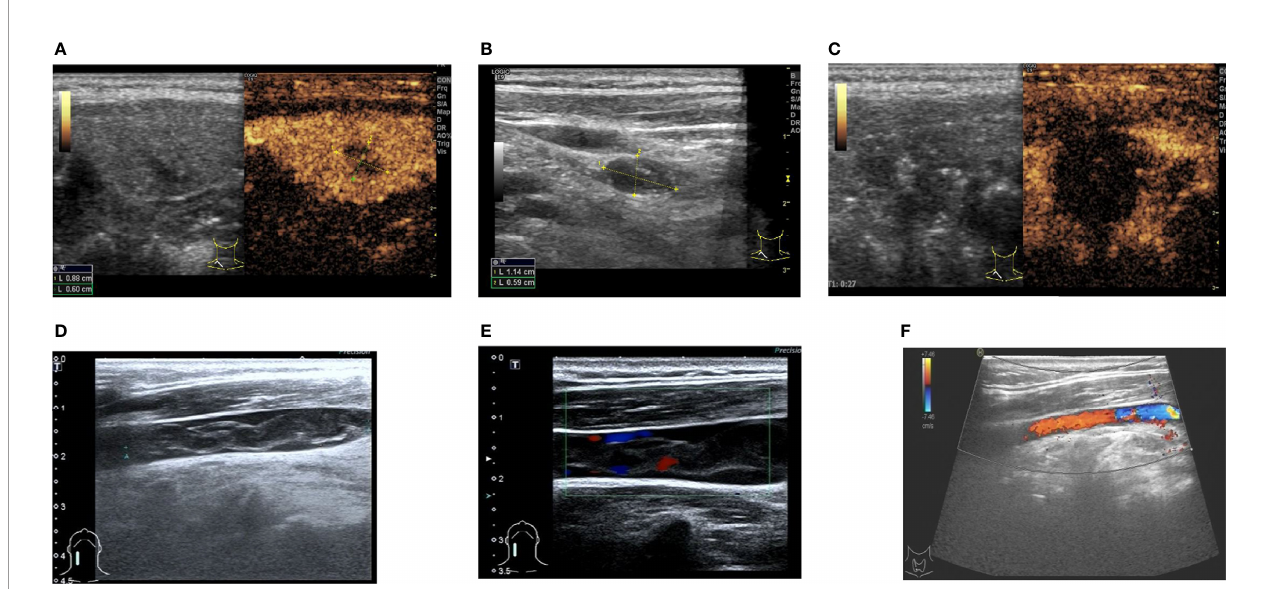
FIGURE 2 | Ultrasound and fl ow chart of Patient #2 after ablation. (A) Preoperative ultrasound of thyroid nodule. (B) Preoperative ultrasound of lymph node. (C) Ultrasound after extended ablation of papillary thyroid carcinoma of the right lobe of thyroid of the patient immediately after postoperative (local no contrast medium fi lling). (D) Two-dimensional ultrasonography of internal jugular vein thrombosis on the second day after ablation. (E) Thrombus fl ow diagram of the right internal jugular vein on the second day after ablation. (F) One week after thrombolysis, venous thrombosis disappeared, and venous blood fl ow returned to